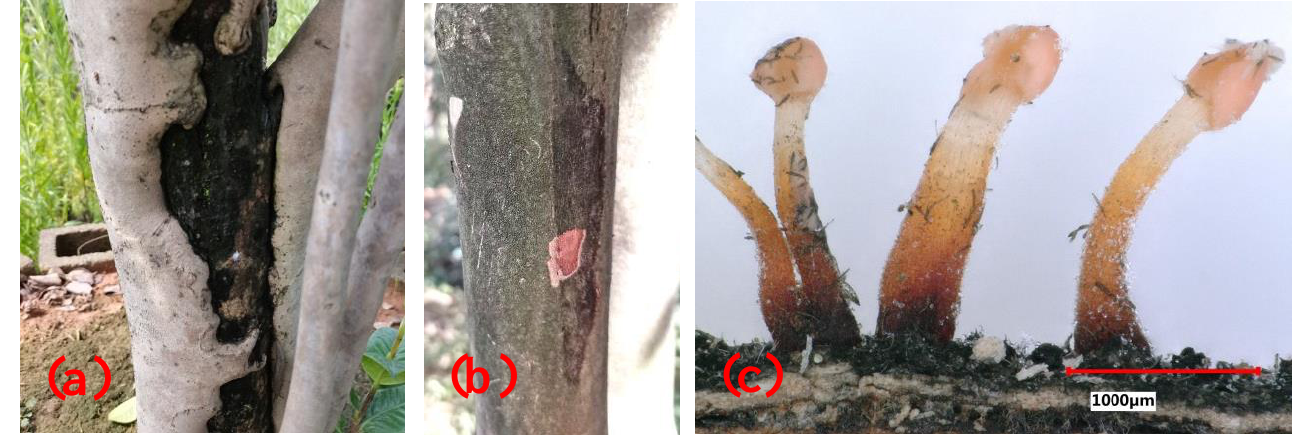
Figure 1. Disease symptoms and synnematal morphology of the pathogenic fungus. ( a , b ) Trunk canker and branch canker observed on C. japonica ‘Hongluzhen’; ( c ) synnemata on diseased bark.